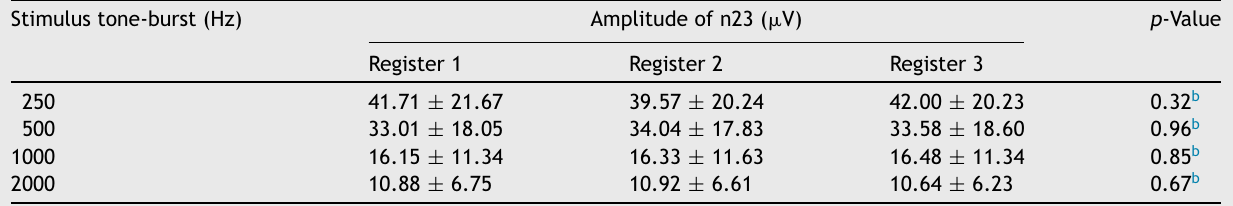
Table 4 Mean values and standard deviation of amplitude of wave n23 (test---retest) of vestibular evoked myogenic potential recorded by different tone-burst stimuli, a ( n = 156 for frequencies of 250 and 500 Hz, n = 152 for 1000 Hz, and n = 136 for 2000 Hz). Stimulus tone-burst